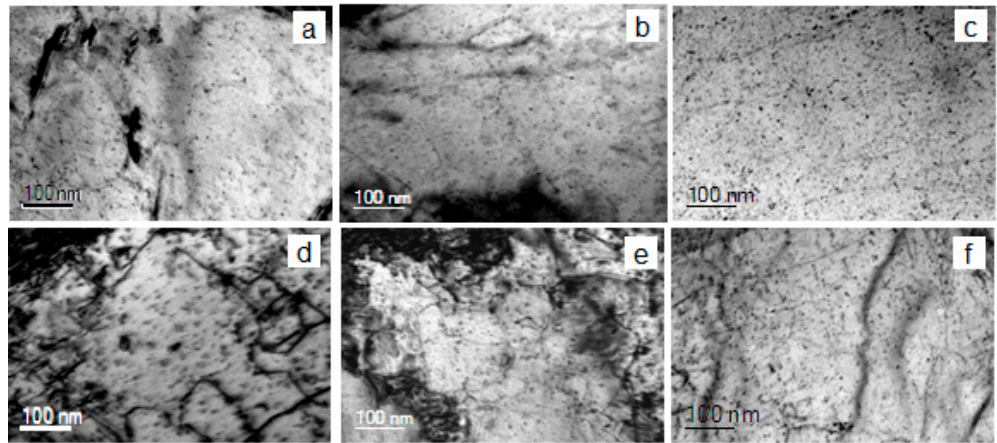
Figure 7. TEM images of precipitates in ( a – c ) Ti ‐ steel and ( d – f ) MoNbTi ‐ steel, after processing according to schedule ( a , d ) A, ( b , e ) B and ( c , f ) C (Figure 1).